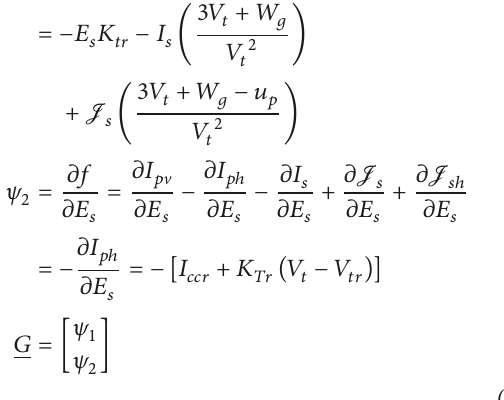
Table 3: Different experimental values of the characteristics ( V